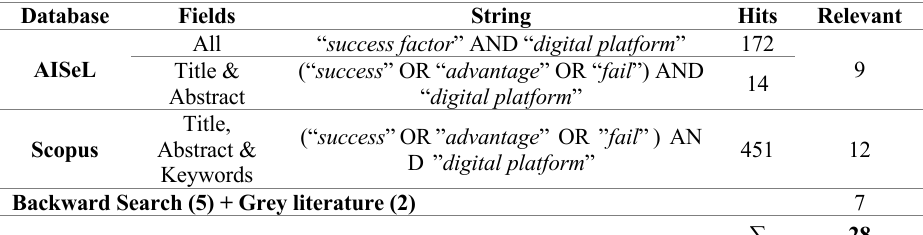
Table 1. Overview of our Literature Search Strategy.